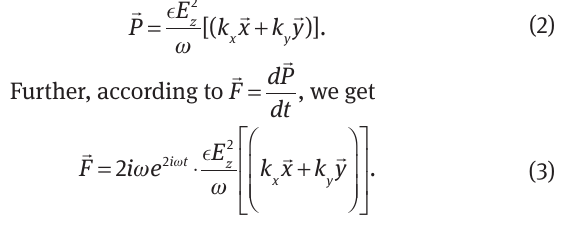
Figure 1: Physical pictures of topological electronic states and topological photonic states. (A) Quantum Hall effects in the electron gas system. Illustration of the cyclotron motions of electrons. corresponds to ELF. (B) Topological photonic states in the magneto-optical system. The red and blue arrows indicate the directions of energy flow and PLF, respectively. The green wavy arrows represent the evanescent electromagnetic